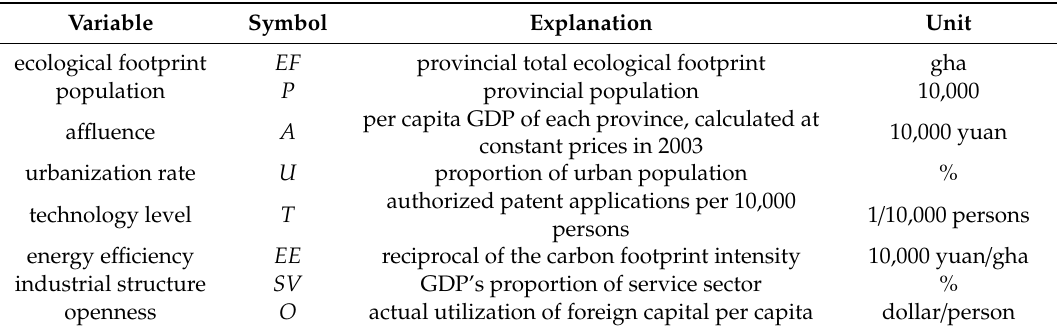
Table 2. List of variables in the regression